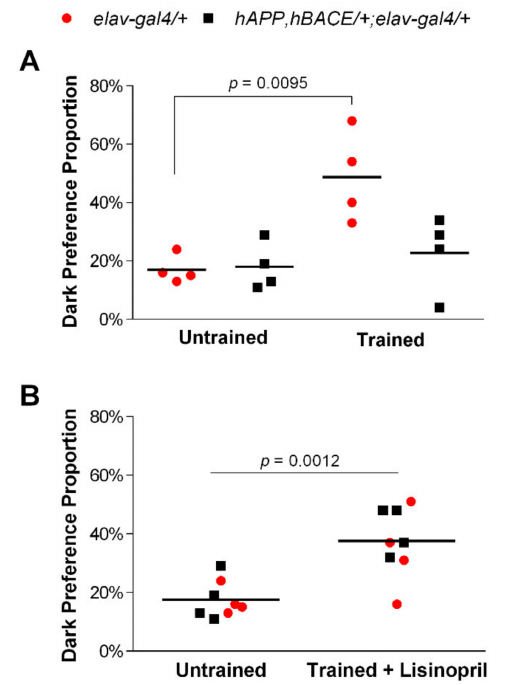
Figure 1. Lisinopril treatment mitigates learning and memory impairments in AD flies. ( A ) Control elav-gal4 / + flies but not hAPP , hBACE / + ; elav-gal4 / + AD flies prefer moving significantly more towards a dark chamber than a light chamber after training. ( B ) A higher proportion of lisinopril- fed flies chose a dark chamber after training, independent of genotype. p -values obtained from Tukey–Kramer post hoc tests for multiple comparisons.